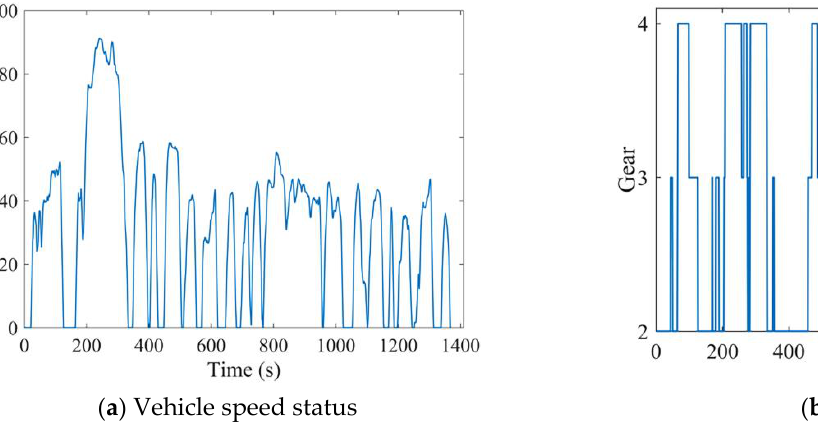
Figure 11. UDDS working condition.